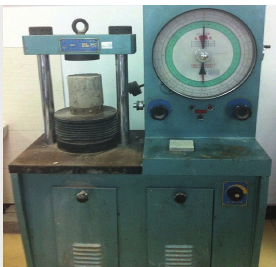
Figure 4: Compressive modulus of resilience